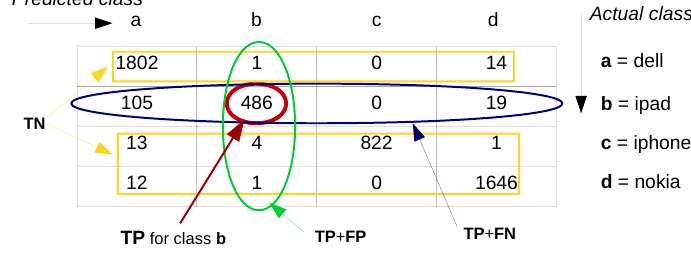
Figure 10. Confusion matrix interpretation for class b